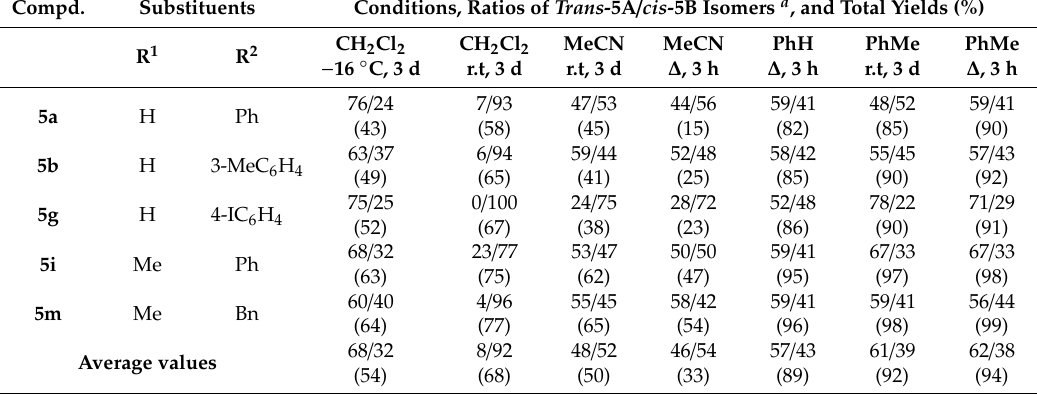
Table 1. Influence of solvents and temperature on the yields and ratios of trans - 5A / cis - 5B isomers of 3-allyl-1-oxo-3a,6-epoxyisoindole-7-carboxylic acids ( 5 ).